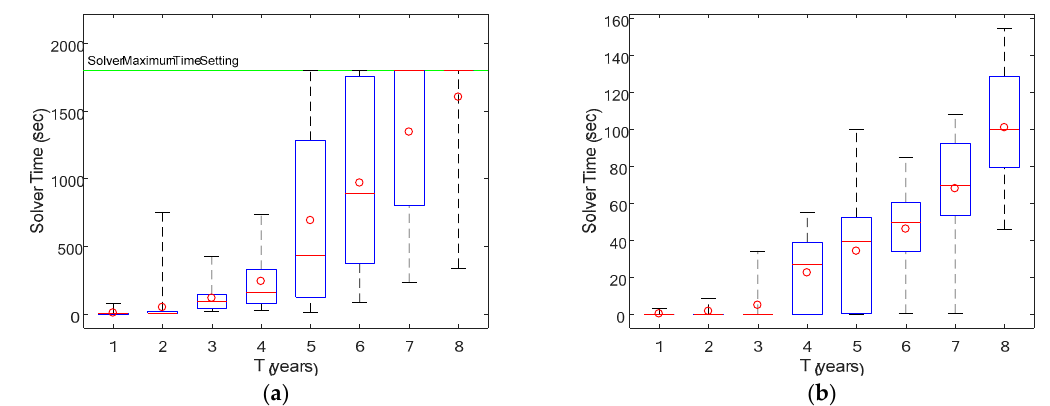
other hand, the worst solution time of the SOH is 155 s.